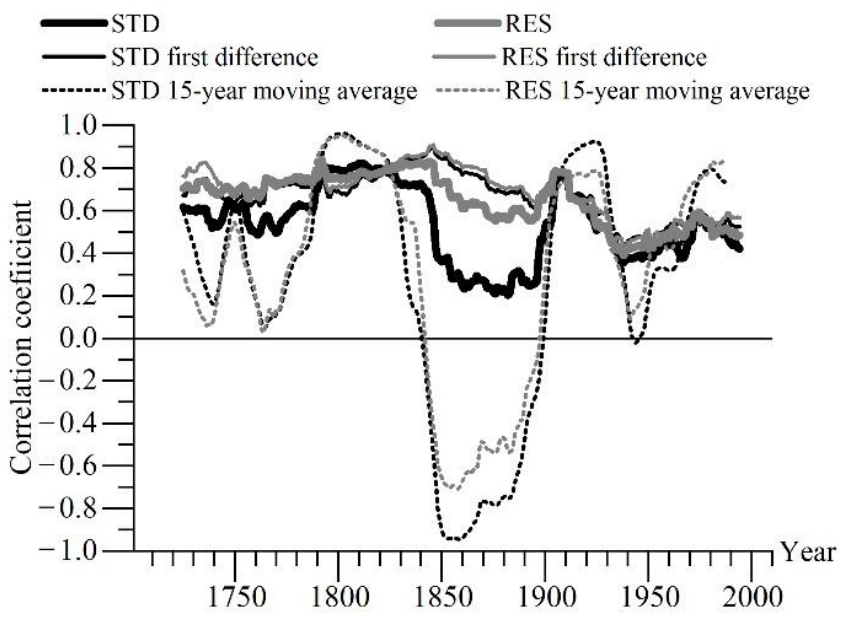
Figure 3. Moving correlations centered on a 50-year window with a 1-year step length between L. speciosa MXD and A. delavayi MXD during 1701 – 2019.